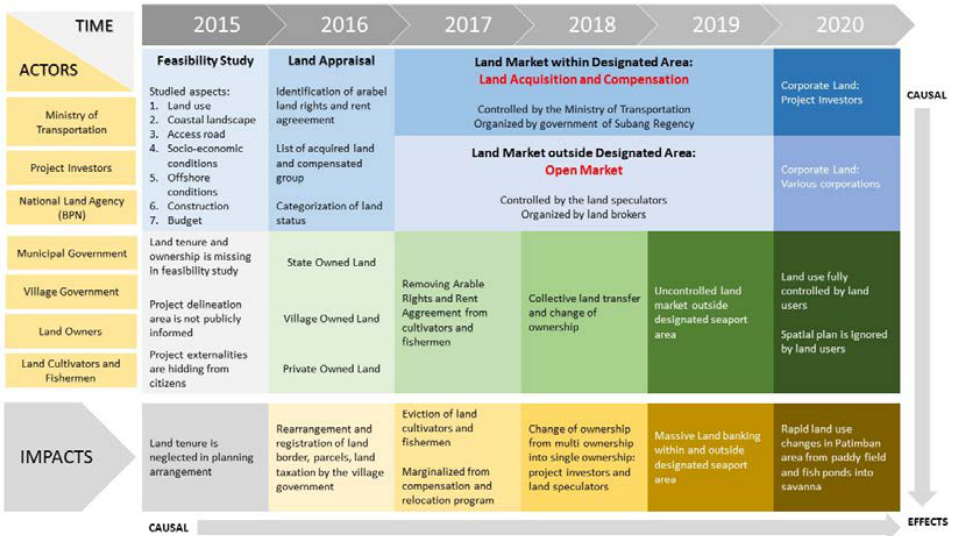
Figure 5. Land Transfer and Impacts (own representation).